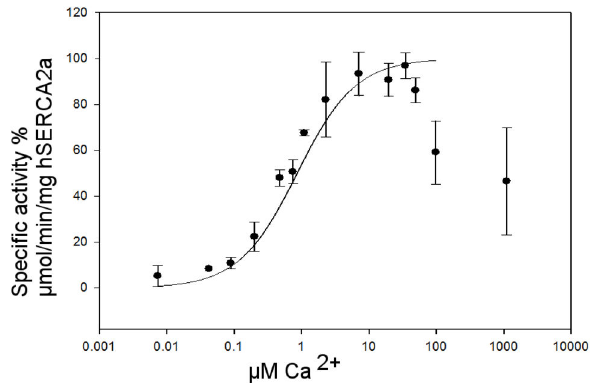
Figure 6. Normalised specific ATPase activity rate versus Ca 2+ dependence for DDM solubilised h SERCA2a after HPLC-SEC purification. 100% specific ATPase activity corresponds to 3 µmol hydrolysed ATP/min/mg of h SERCA2a. The results are the means of seven measurements, using protein obtained from three independent membrane preparations; error bars represent ±S.D. doi: